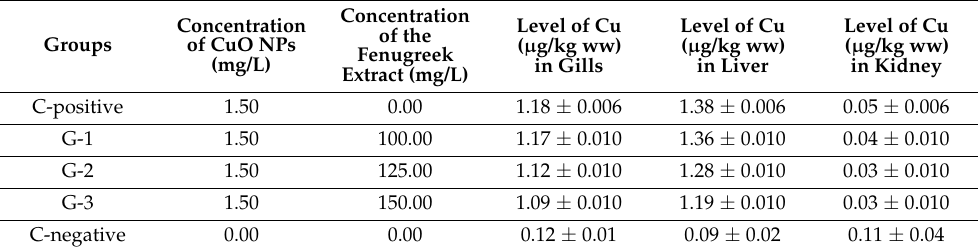
Table 2. Concentration of Cu ( µ g/kg ww) in gills, livers, and kidneys of the common carp ( C. carpio ) experimentally exposed to CuO NPs and different concentrations of the fenugreek ( T. foenum-graecum ) extract for 28 days. Data are expressed as means ± standard error (SE; n = 10).